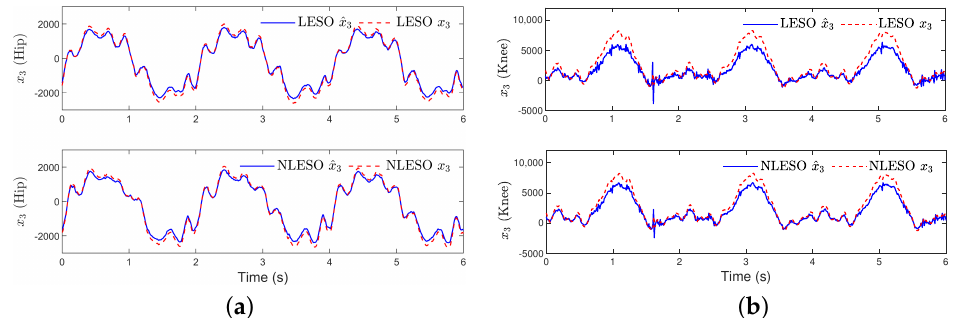
Figure 5. The state variable x 3 and its estimation ˆ x 3 from the LESO (upper subfigure) and NLESO (lower subfigure) observers for the hip ( a ) and knee ( b )